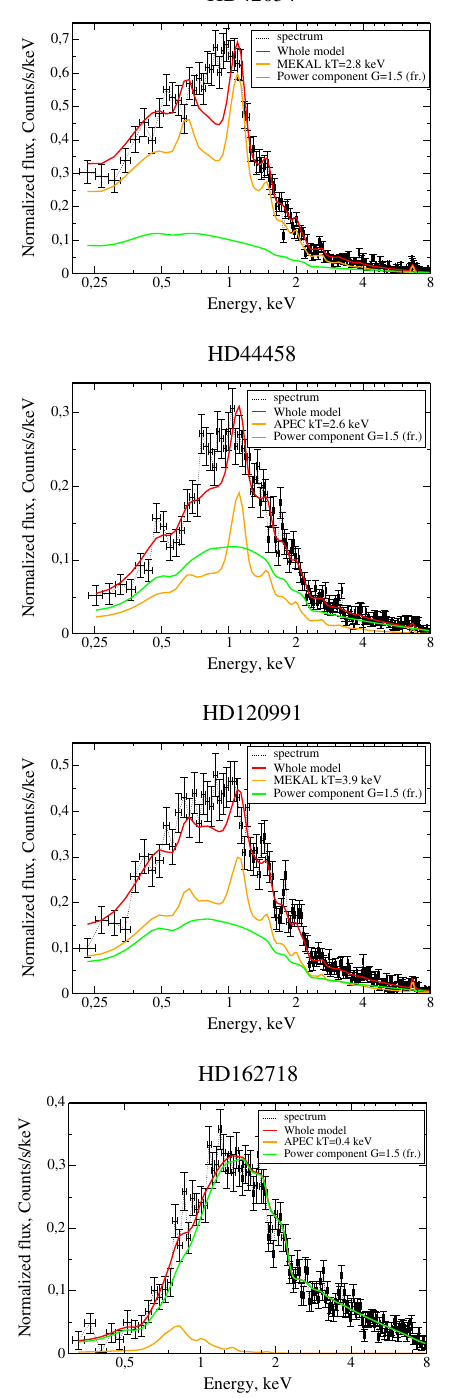
Figure 3. The same as in Figure 1 but for APEC/MEKAL+PL models. seen from the figure and from data in Table 3 it is mandatory to use high plasma temperature, since an excess of X-ray radiation in the 2-8 keV range can be reproduced only for extremely high plasma temperatures up to kT ∼ 40 keV.